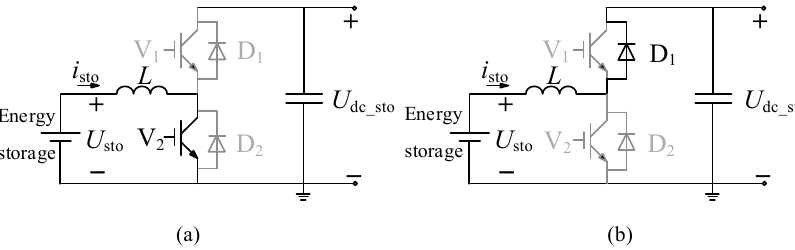
Figure 5. Topology and working mode of bi-directional DC / DC converter in Boost mode: ( a ) Conduction period of V 2 ; ( b ) Shutdown period of V 2 .